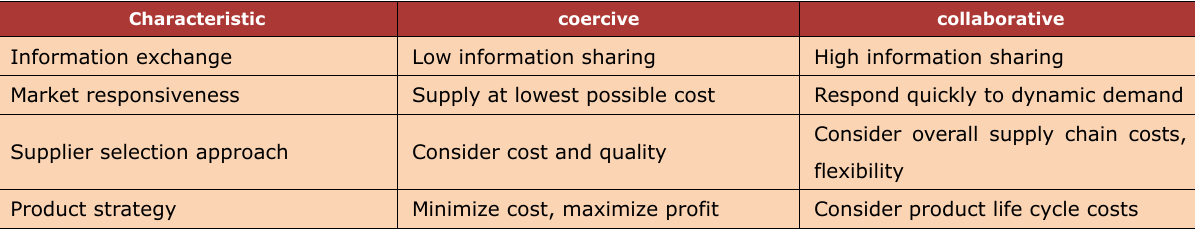
Table 2. An analysis of coercive versus collaborative supply chain relationships